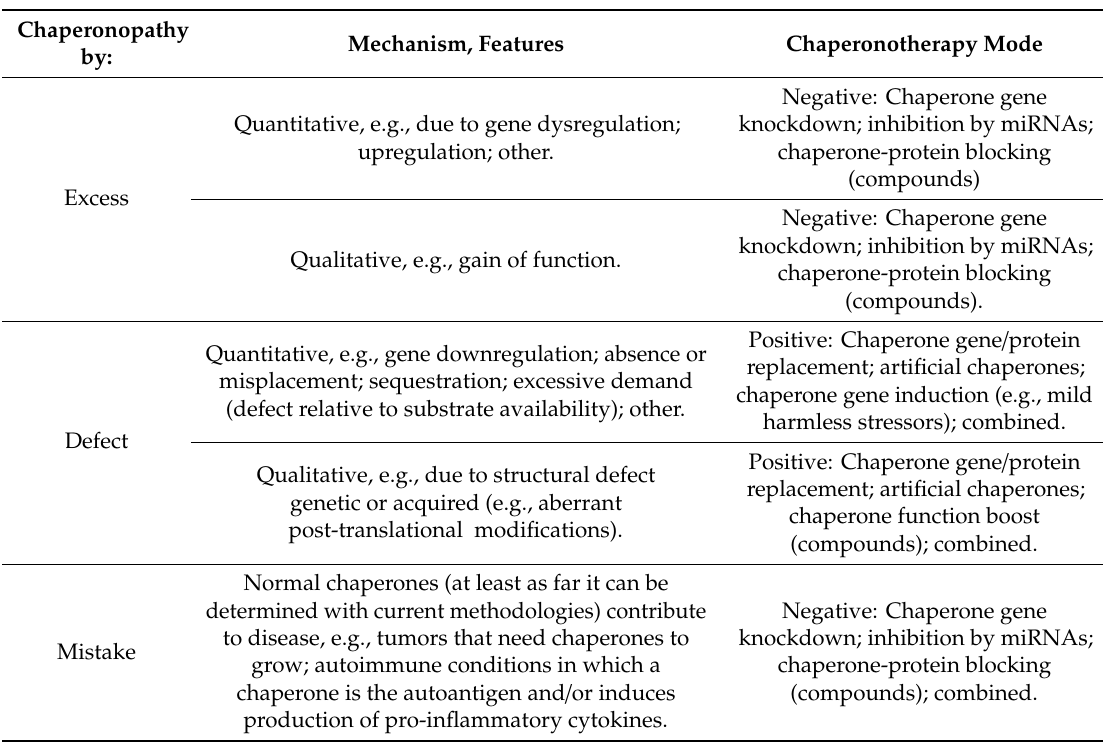
Table 2. Chaperonopathies grouped according to the type of chaperone abnormality and pertinent chaperonotherapy